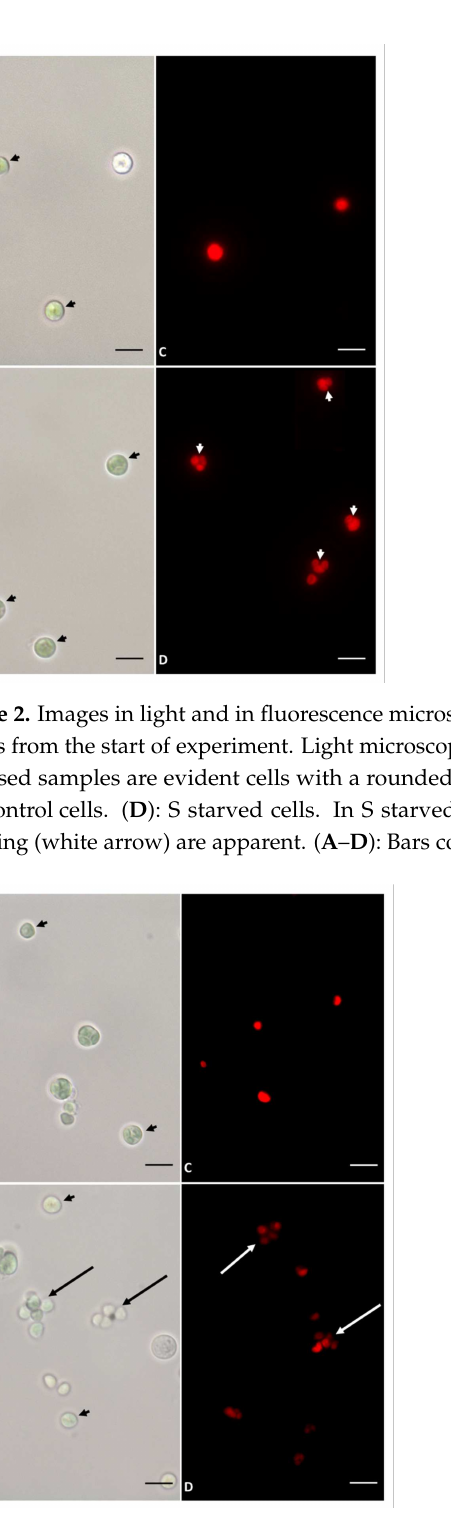
Figure 3. Images in light and in fluorescence microscopy of Galdieria sulphuraria cells collected after 7 days from the start of the experiment. Light microscopy: ( A ): control cells. ( B ): S starved cells. In both analysed samples, cells with a rounded shape (black arrow) are evident. In the S starved ( B ) cellular aggregates (black long arrow) are evident. Fluorescence microscopy: ( C ): control cells. ( D ): S starved cells. In S starved cells cellular aggregates (white long arrow) are evident. ( A – D ): Bars correspond to 5 µ